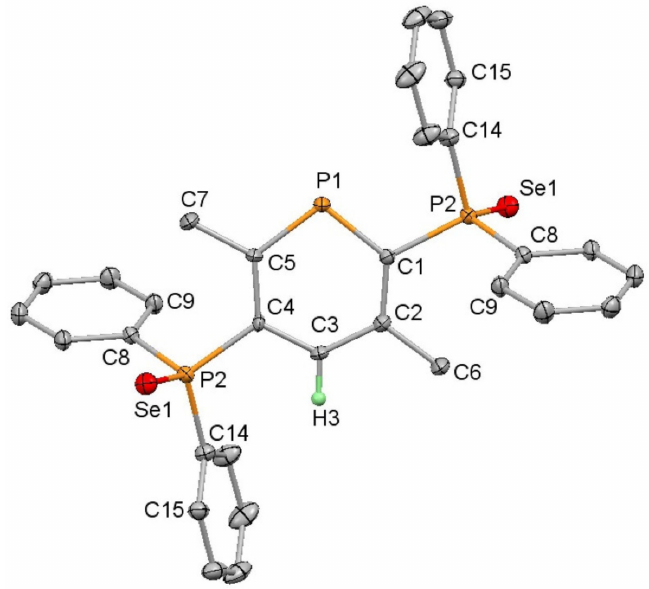
Figure 2. Molecular structure of 8 (thermal ellipsoids at 50%; all H atoms except for those attached to the heterocyclic ring have been omitted for clarity). Only one position of the disordered phosphinine ring is